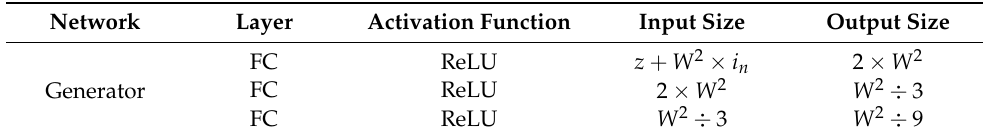
Table 3. Detail of Table 3. Detail of Generator.